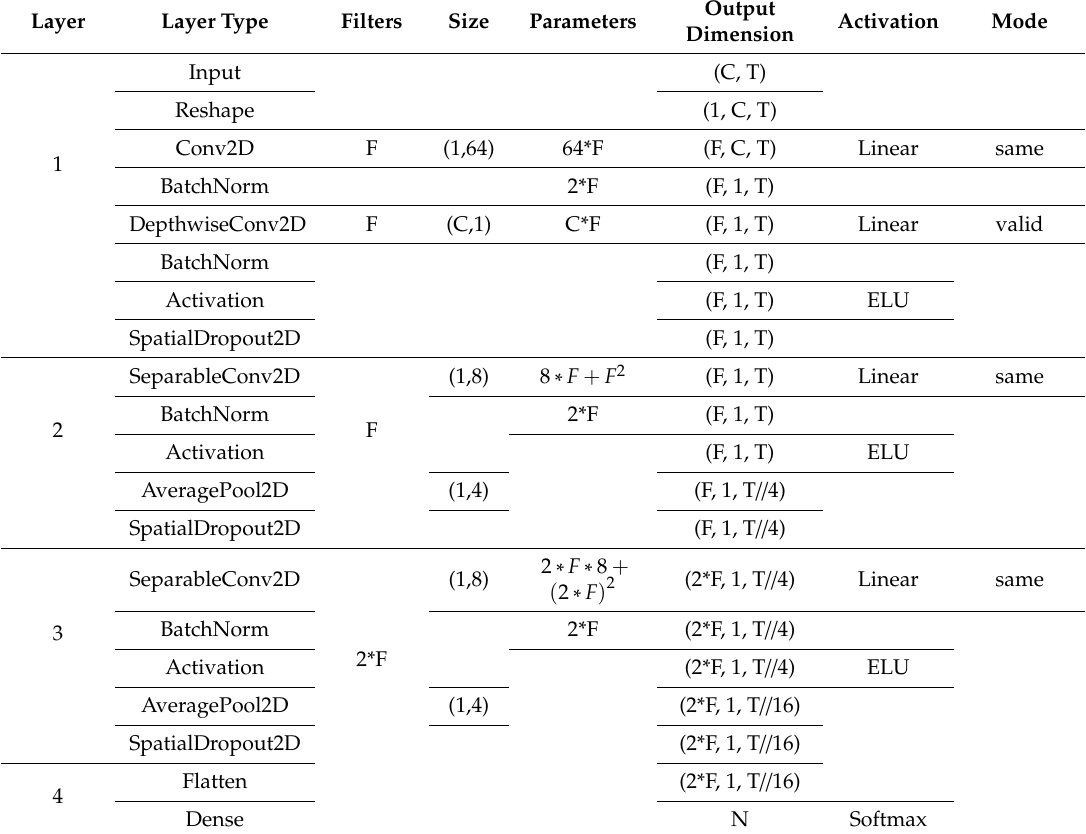
Table 1. Details of the EEGNet